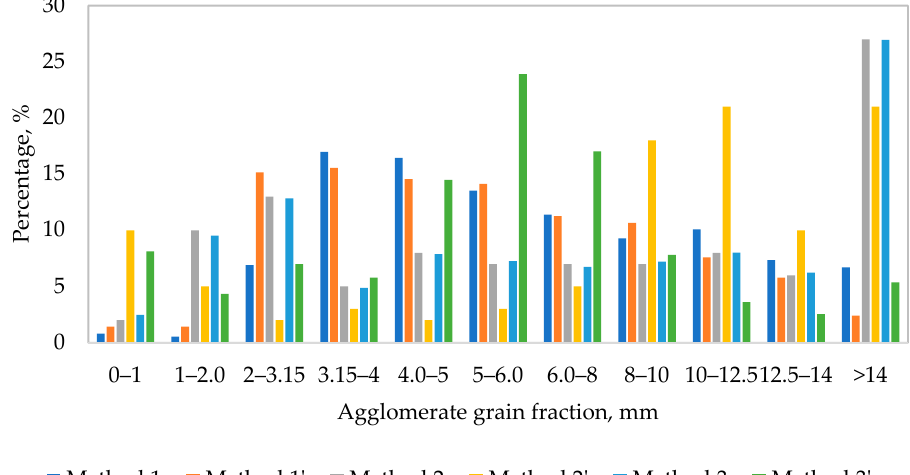
Figure 2. Granulate grain-size (Methods 1, 2, 3; two examples per each method).